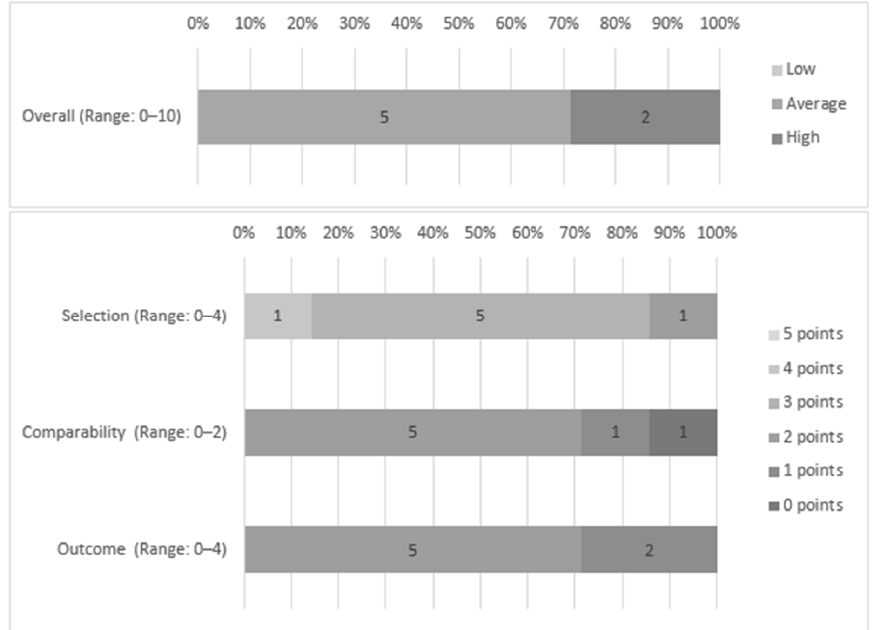
Figure 2. General and criteria scores of the studies through the Ottawa–Newcastle (NOS)